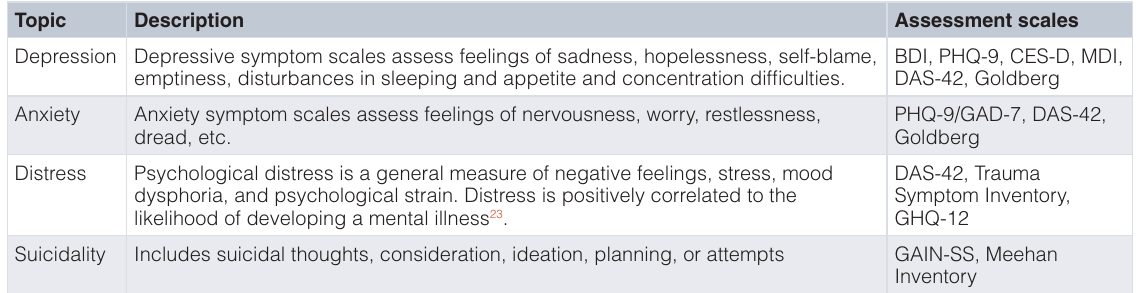
Table 2. Summary of the topics covered in this paper. Please refer to Table 1 for abbreviations. Topic